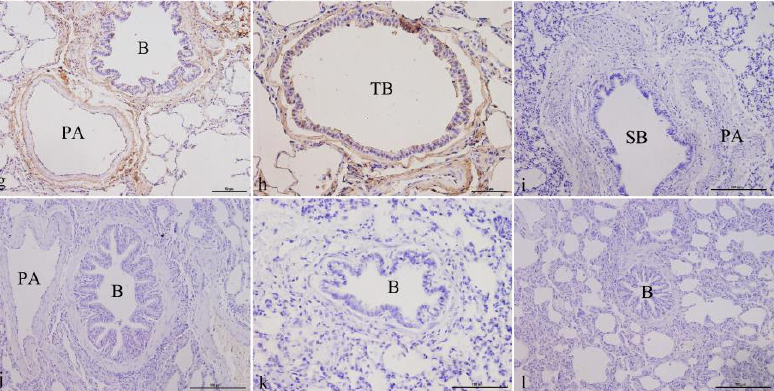
Figure 3. ATP6V1C2 localization in yak lungs at different ages. ( a ) Small bronchi of yak lungs in the newborn group (200×). ( b ) Small bronchi and pulmonary arteries of yak lungs in the newborn group (200×). ( c ) Bronchioles of yak lungs in the juvenile group (400×). ( d ) Bronchioles and pulmonary arteries of yak lungs in the juvenile group (400×). ( e ) Bronchioles of yak lungs in the adult group (400×). ( f ) Pulmonary arteries of yak lungs in the adult group (400×). ( g ) Bronchioles and pulmonary arteries of yak lungs in the elderly group (400×). ( h ) Terminal bronchioles of yak lungs in the elderly group (400×). ( i ) Blank control of small bronchi and pulmonary arteries of yak lungs in the newborn group (200×). ( j ) Blank control of bronchioles and pulmonary arteries of yak lungs in the juvenile group (200×). ( k ) Blank control of bronchioles of yak lungs in the adult group (200×). ( l ) Blank control of bronchioles of yak lungs in the elderly group (200×). SB — small bronchi; B — bronchiole; TB — terminal bronchiole; PA — pulmonary artery.